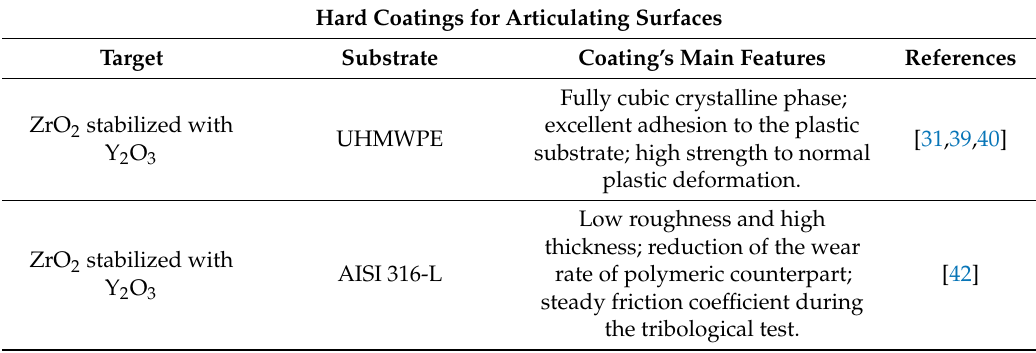
Table 1. Summary of the available literature on PED technology for biomedical